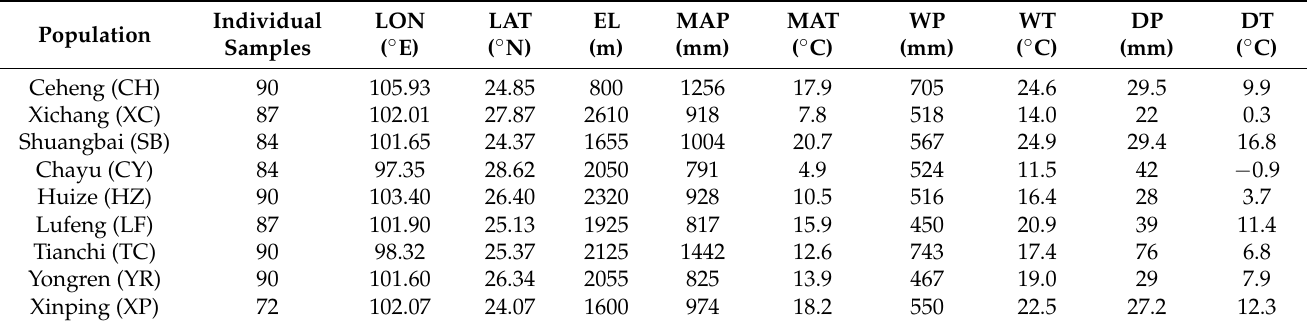
Table 1. Geographical locations and main climatic conditions for the nine P. yunnanensis popula- tions